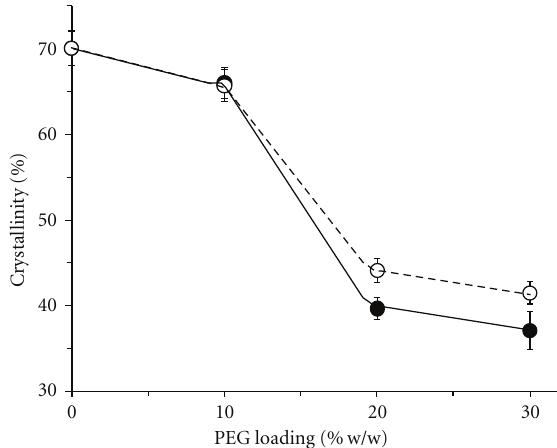
Figure 4: Change in crystallinity of PHB/PEG composite films with variations in PEG loading (% w/w); ( • ) PEG106 and ( ◦ )